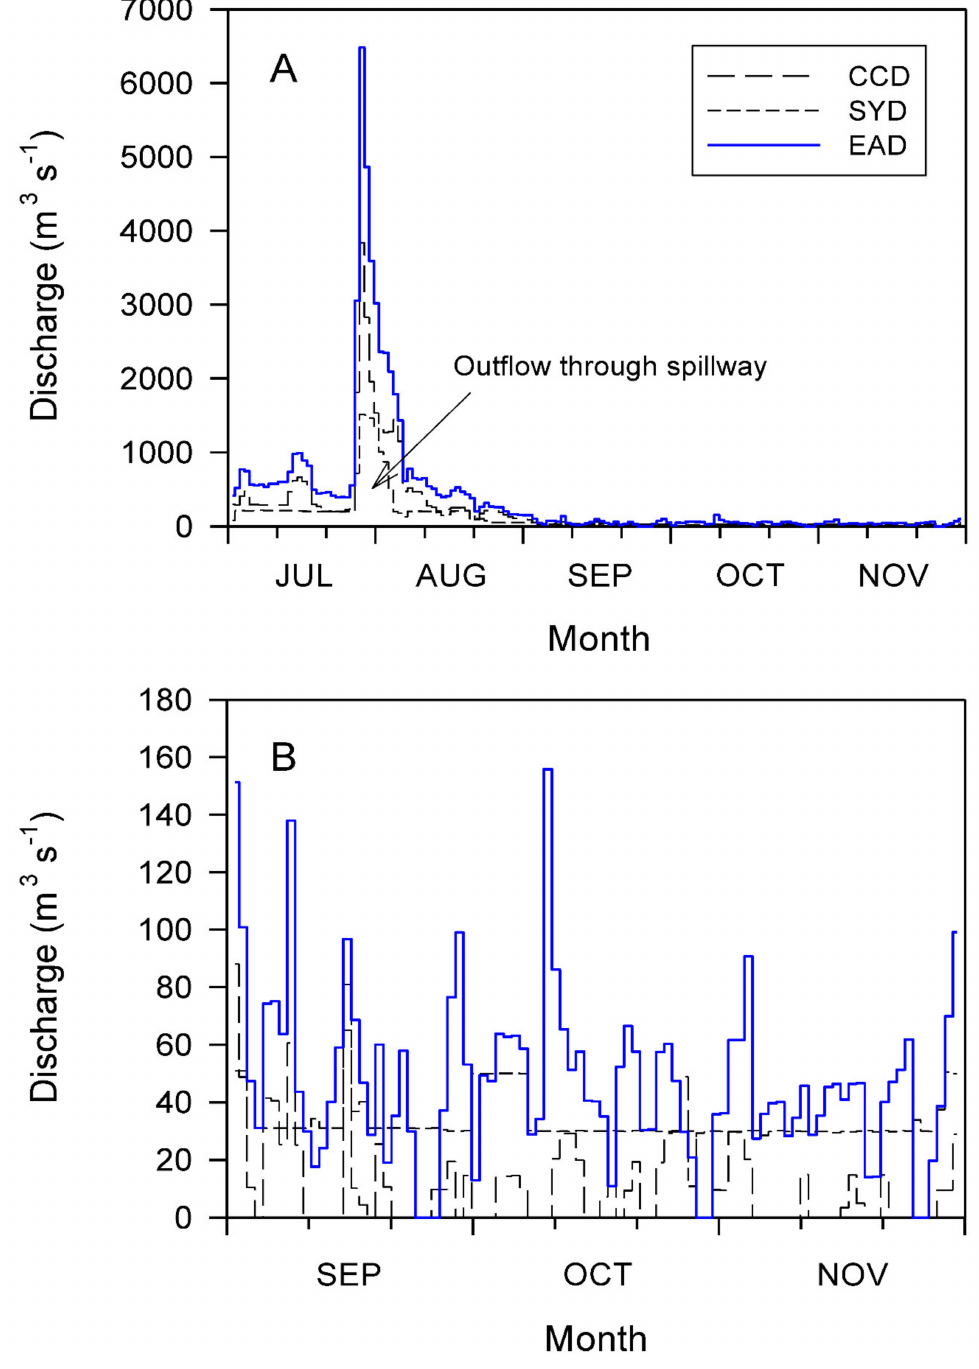
Figure 2. ( A ) Daily fluctuations in the outflow of the Chuncheon, Soyang, and Euiam Reser- voirs (CCD, SYD, and EAD, respectively) of the North Han River from July to November 2011. ( B ) Expanded view from September to November